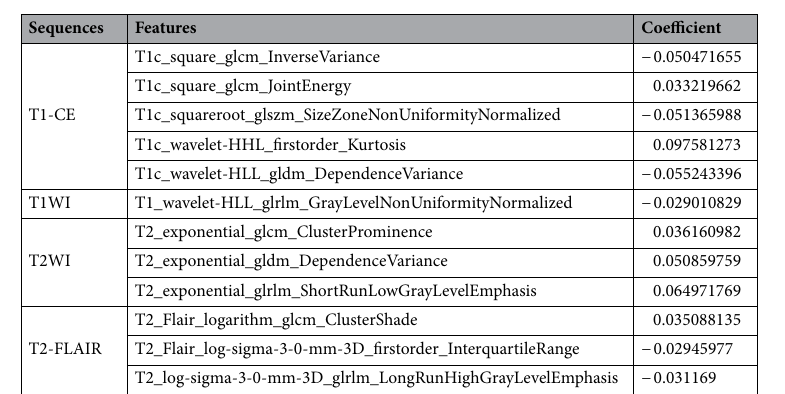
Table 3. Selected features and their coefficient weights in LASSO feature selection